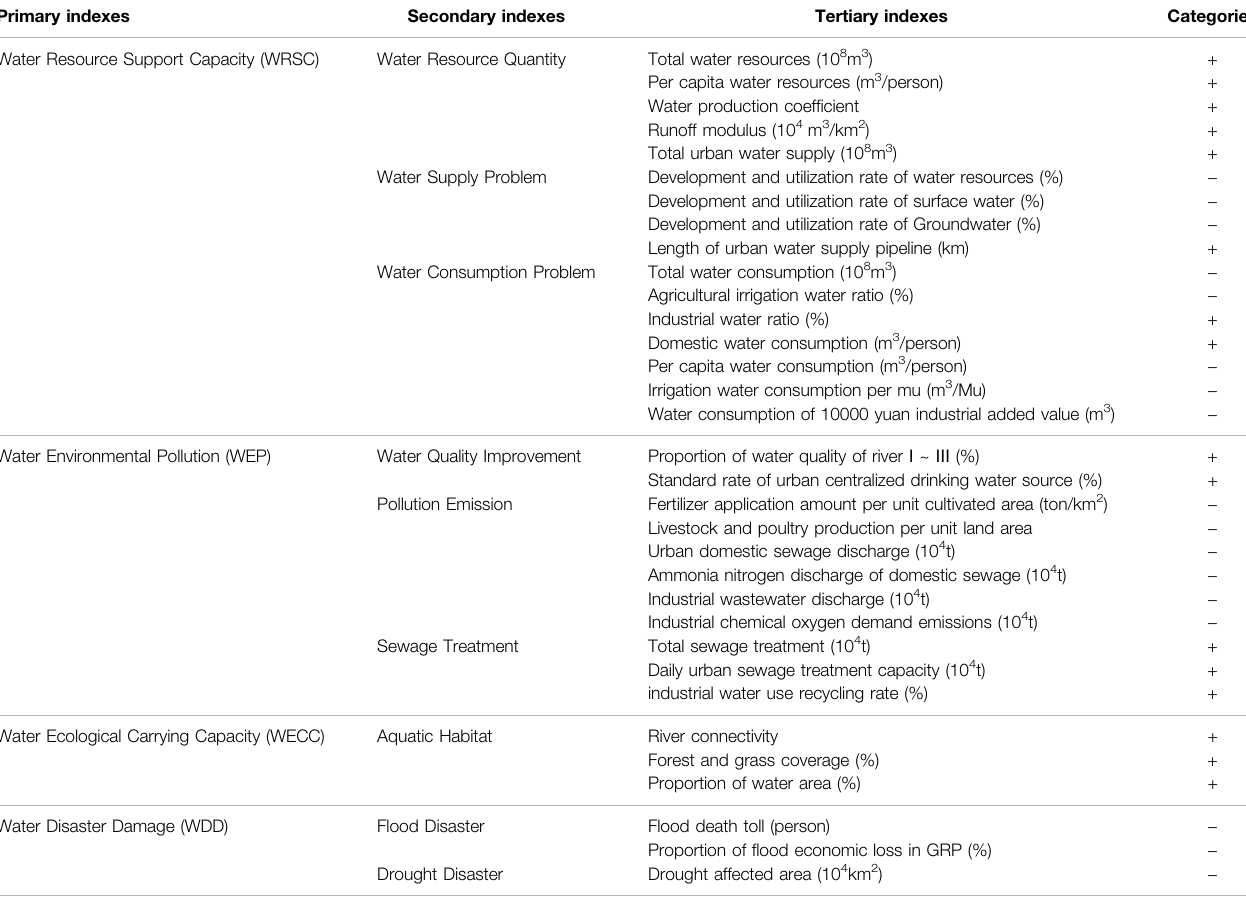
TABLE 1 | Water resources evaluation index